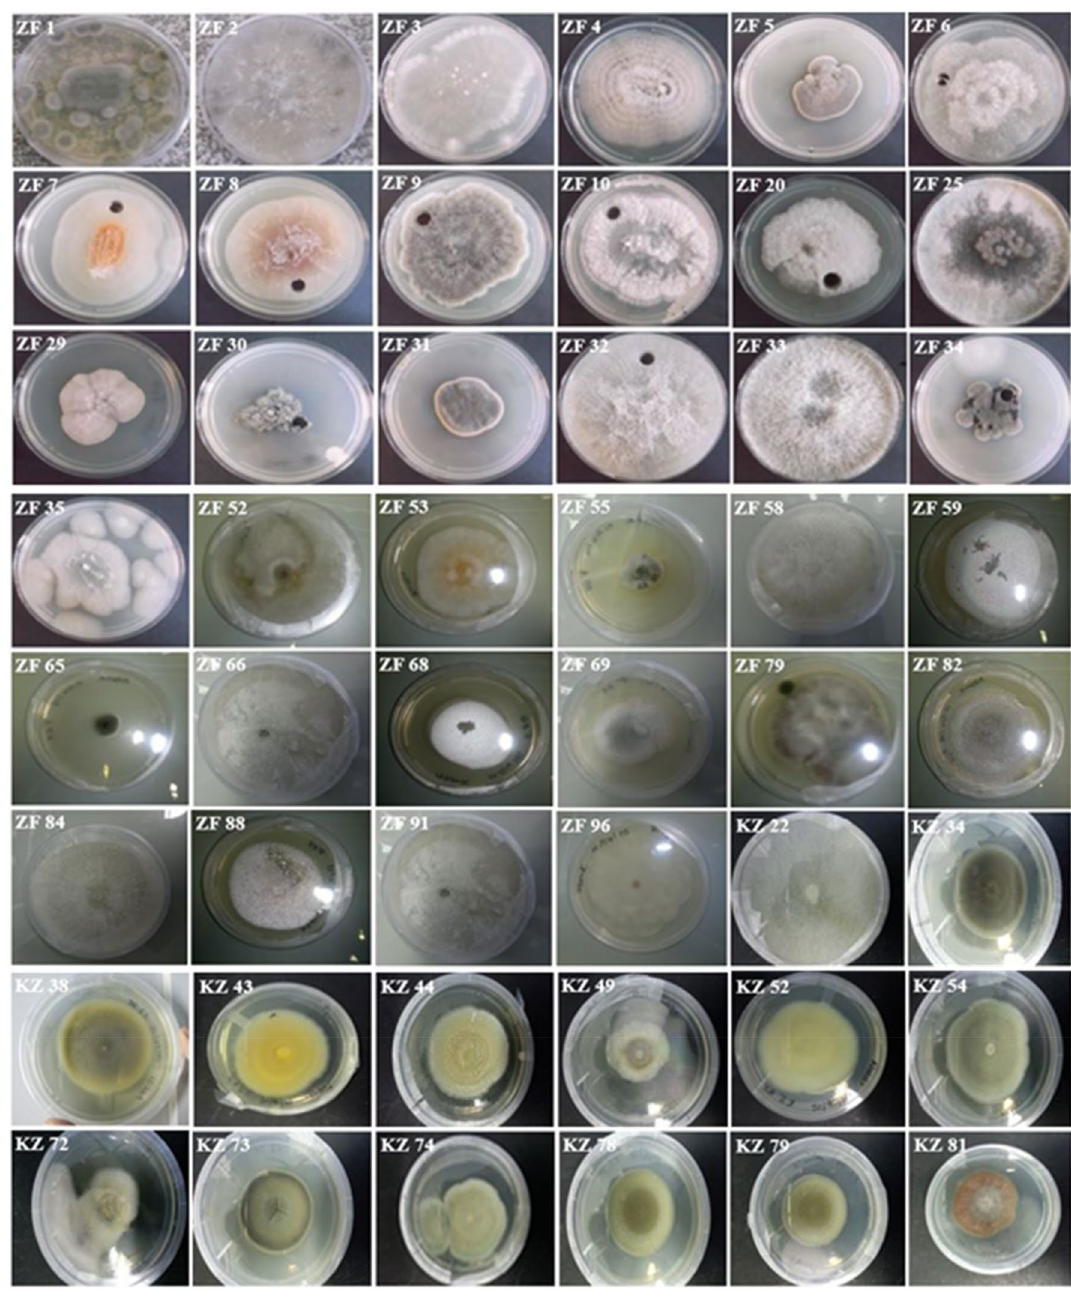
Figure 1. Pure fungal cultures identified from Kigella africana